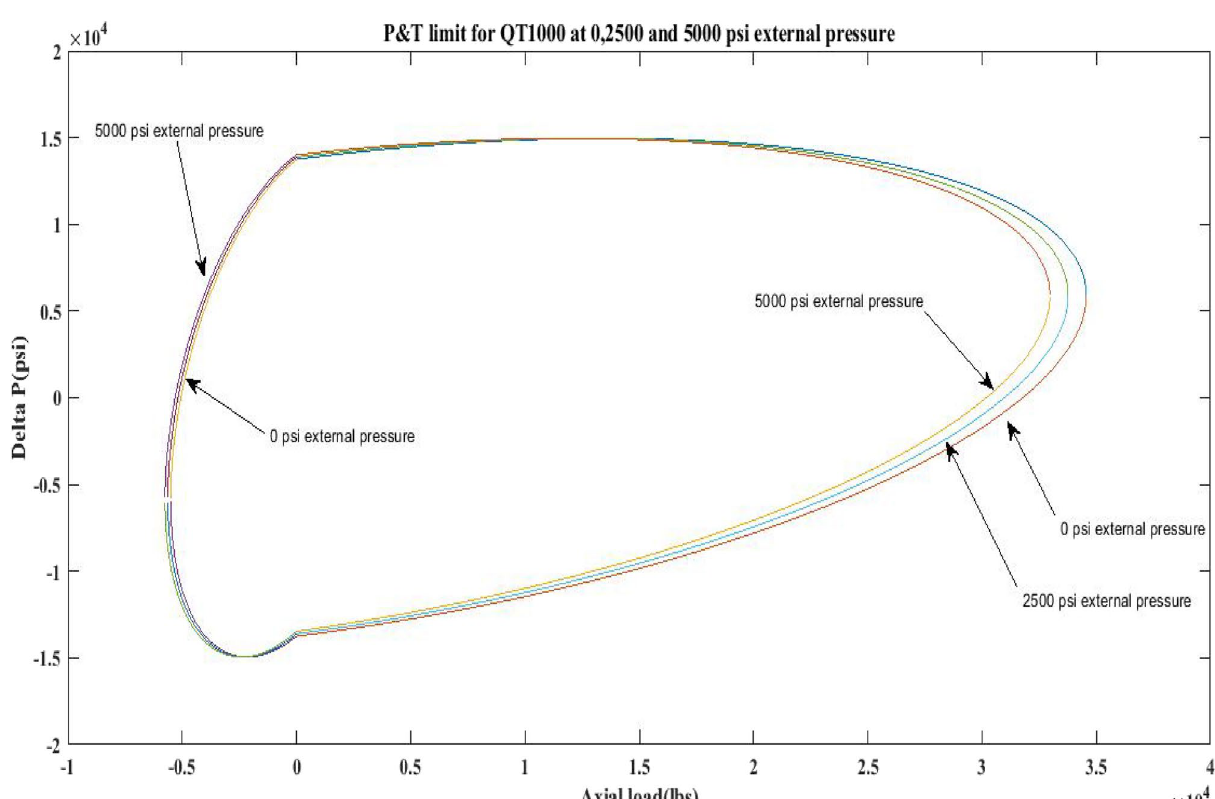
Figure 4. Pressure and tension limits for QT 1000 at 0, 2500 psi and 5000 psi external